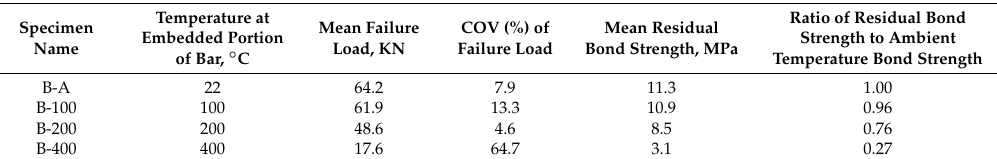
Figure 6. The bond specimens after bond failure. ( a ) Side view of B-A specimen after bond failure; ( b ) B-A specimen showing embedded portion of bar after failure of specimen; ( c ) side view of B-100 specimen after bond failure; ( d ) B-100 specimen showing embedded portion of bar after failure of specimen; ( e ) side view of B-200 specimen after bond failure; ( f ) B-200 specimen showing embedded portion of bar after failure of specimen; ( g ) side view of B-400 specimen after bond failure; ( h ) B-400 specimen showing embedded portion of bar after failure of specimen. Table 3. Summary of Bond Test Results.